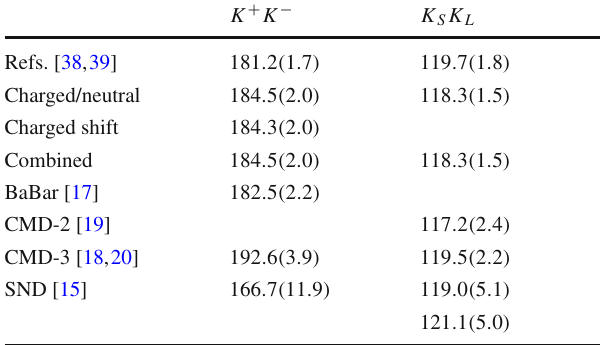
Table3 Resultsforthecharged-andneutral-kaoncontributionstoHVP √ s ≤ 1 . 05GeV, in units of 10 − up to